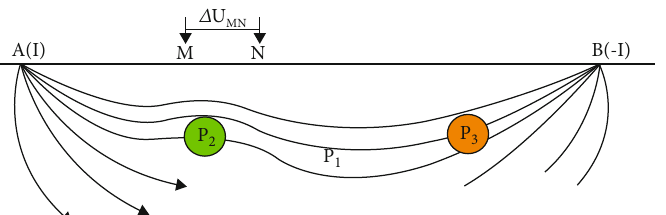
Figure 10: Working principle of the electric resistivity tomography. When the current propagates through underground, due to di ff erent lithology and fracture development in the underground space, the formation resistivity at di ff erent locations in the underground space is as shown by ρ 1, ρ 2, and ρ 3. The current density is also di ff erent, as shown in the dense and sparse distribution of current schematic lines. The resistivity value was calculated through the collected potential di ff erence ( Δ UMN), after which the geological anomaly was divided through the resistivity value to realize the spatial display of geological information.